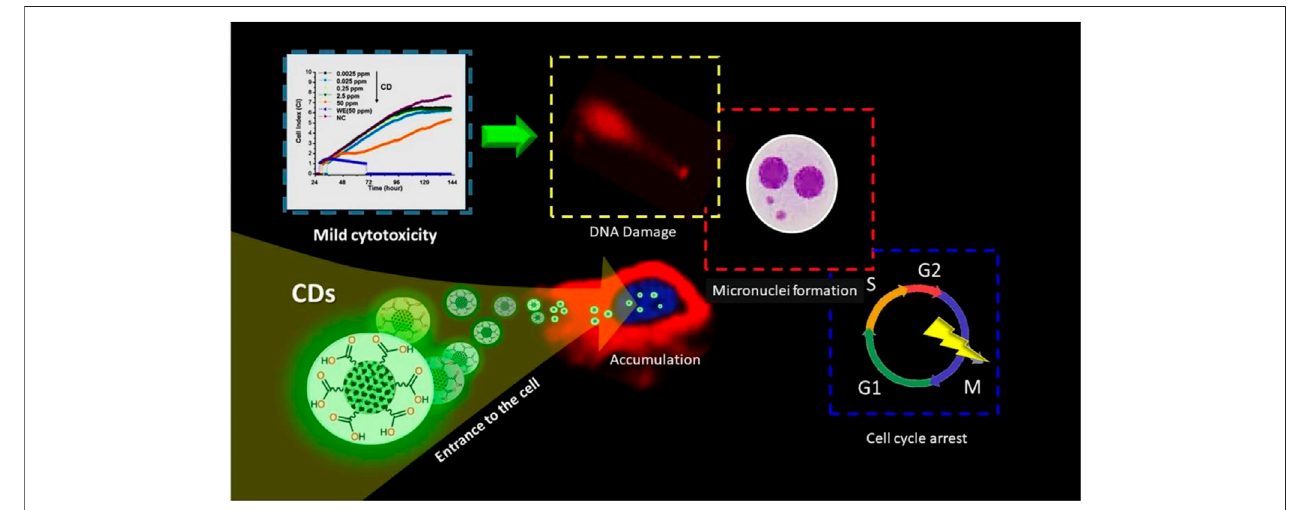
FIGURE 12 | Green fl uorescent carbon quantum dots (CQDs) for cell labeling and Near Infra-Red (NIR) light exposed therapy (Meena et al., 2019).